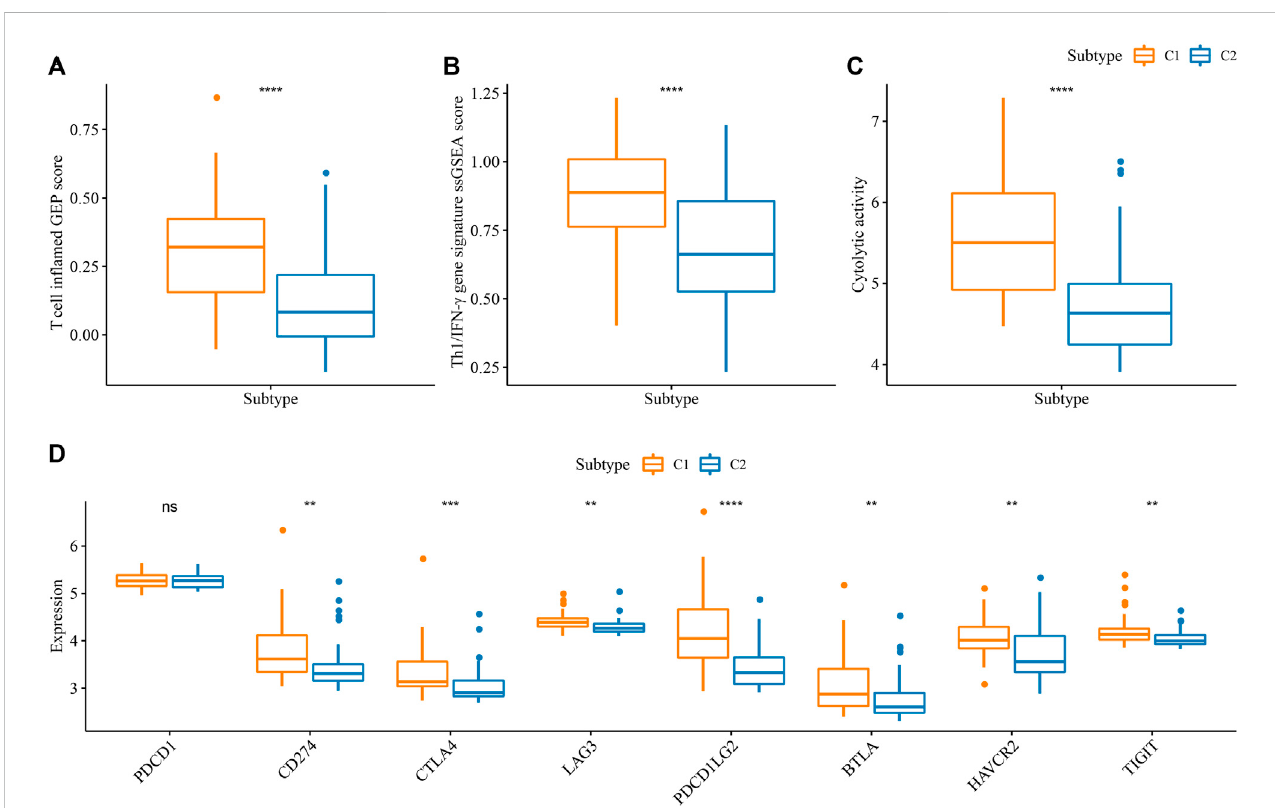
FIGURE 4 Predictionof the response to immunotherapy in E-MTAB-6389 cohort. (A – C) Comparison of ssGSEA score of T cell in fl amed GEP, Th1/IFN- γ signature, and cytolytic activity in C1 and C2. (D) The expression of key immune checkpoints in C1 and C2. Wilcoxon test was conducted. ns, not signi fi cant. ** p < 0.01, *** p < 0.001, **** p <